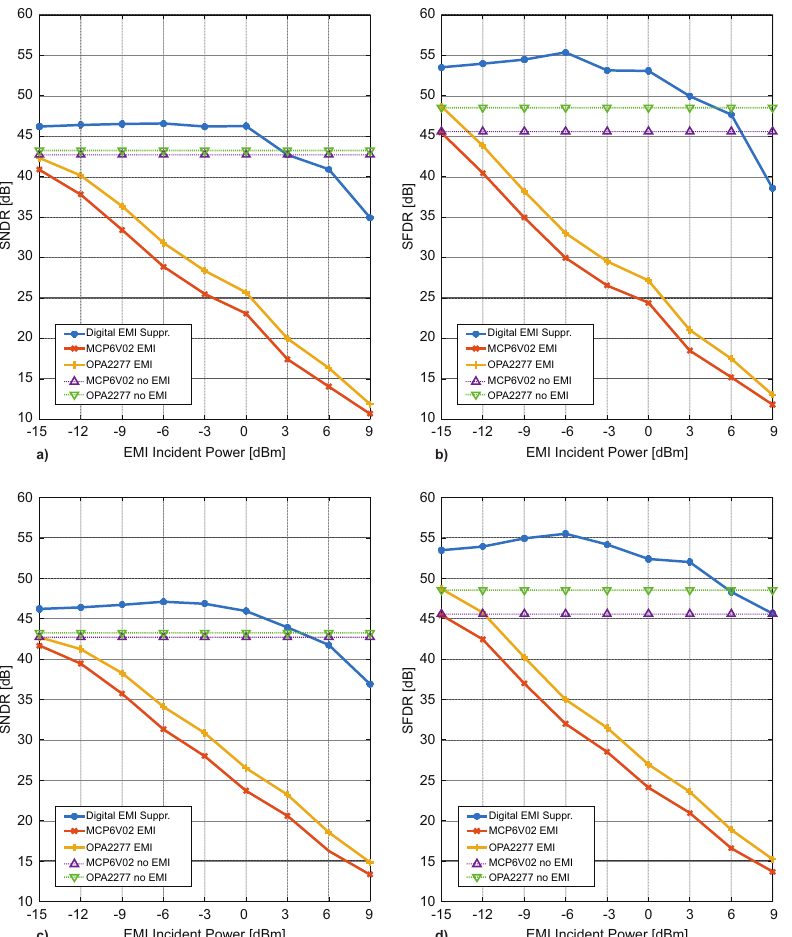
Figure 13. Measured SNDR and SFDR of the waveforms obtained by the proposed EMI suppression technique with α = 0.445 (blue line, * marker), at the MCP6V02 output (red line, x marker), at the OPA2277 output (yellow line, + marker) in the presence of AM modulated EMI with carrier frequency 100MHz, square wave and sine-wave modulating signal at 100% modulation index, for an EMI incident power ranging from − 15 dBm up to 9 dBm: ( a ) SNDR vs. incident power for square wave AM; ( b ) SFDR vs. incident power for square wave AM; ( c ) SNDR vs. incident power for sine wave AM; ( d ) SFDR vs. incident power for sine wave